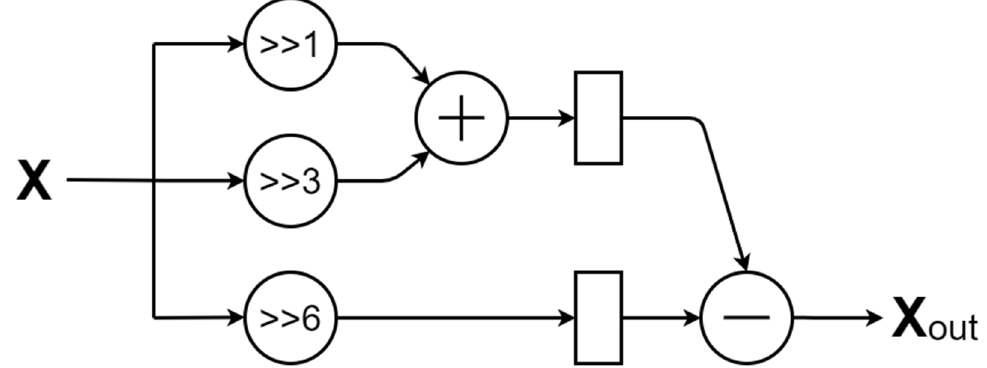
Figure 10. The architecture of the hardware-sharing machine CORDIC scale factor.